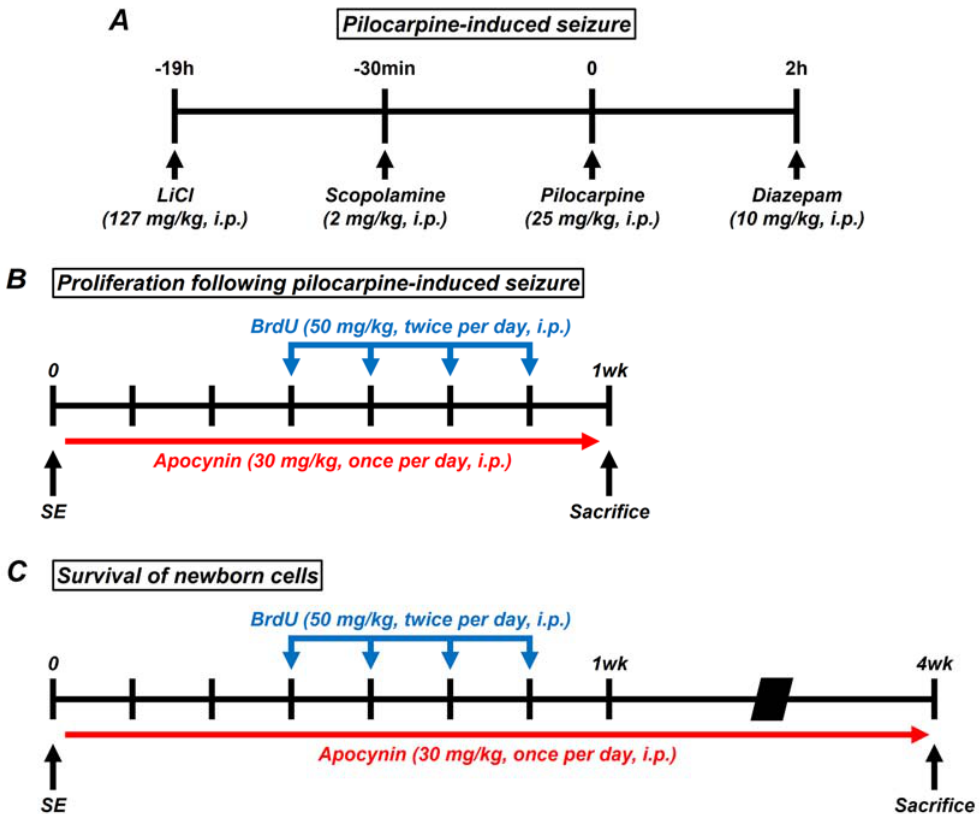
Figure 7. ( A ) Schematic of pilocarpine-induced seizure. Lithium chloride (LiCl 127 mg/kg, i.p.) was administered 19 h before induction of seizure by pilocarpine. Scopolamine (2 mg/kg, i.p.) was